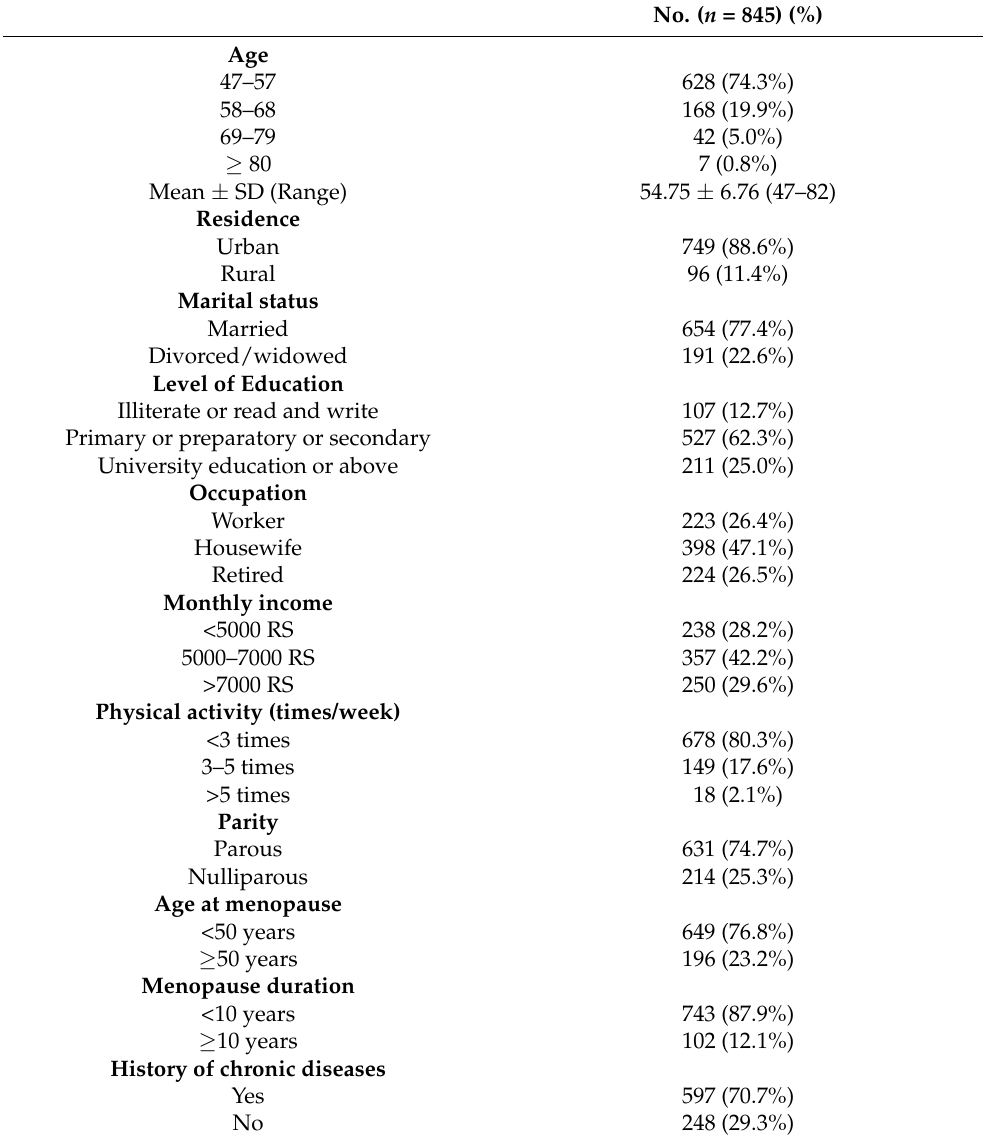
Table 1. Sociodemographic characteristics and menopausal history of Saudi women attending different primary health